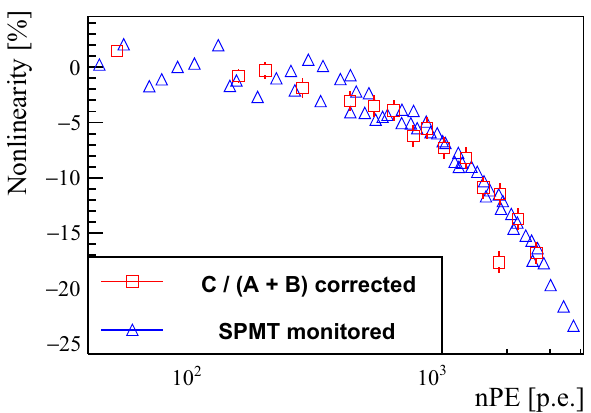
Fig. 31 Measured linearity of a 20-inch PMT by double-LED method (C/(A+B)) (red rectangular) and cross checking with 3-inch PMT (SPMT monitored) (blue triangle)